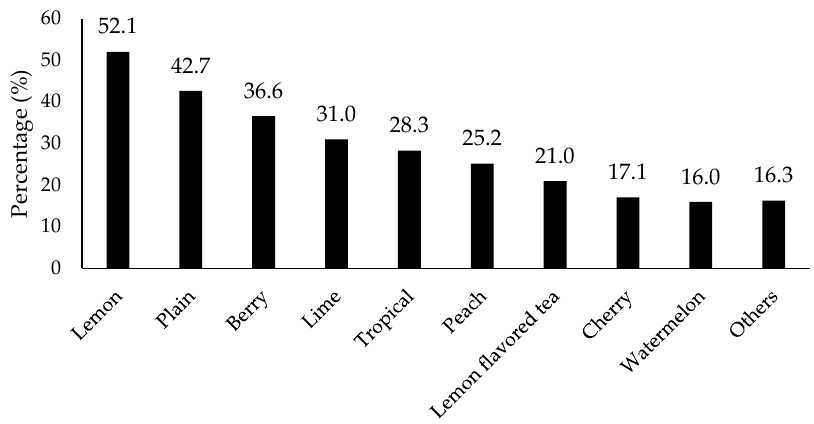
Figure 5. Percentage for the types of flavors for flavored water/beverages that consumers drank the most ( n = 901). Others included orange, grapefruit, raspberry, strawberry, blackberry, pineapple, mango, pomegranate, grape, apple, kiwi, fruit punch, passion fruit, cucumber, mint, vanilla, coconut, and cola according to the collected data.